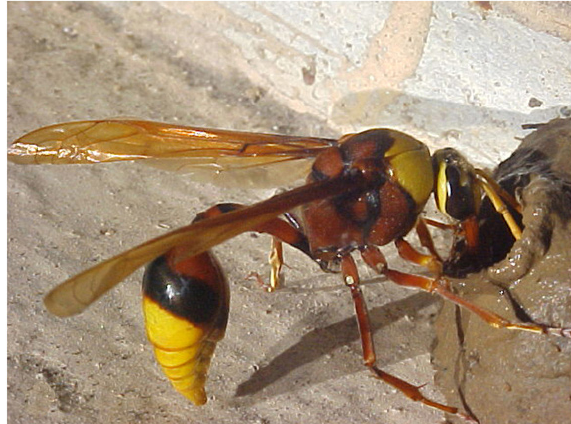
Male: Structure similar to female in general appearance but slighter, the fifth and sixth gastral segments at base and the whole of the seventh segment